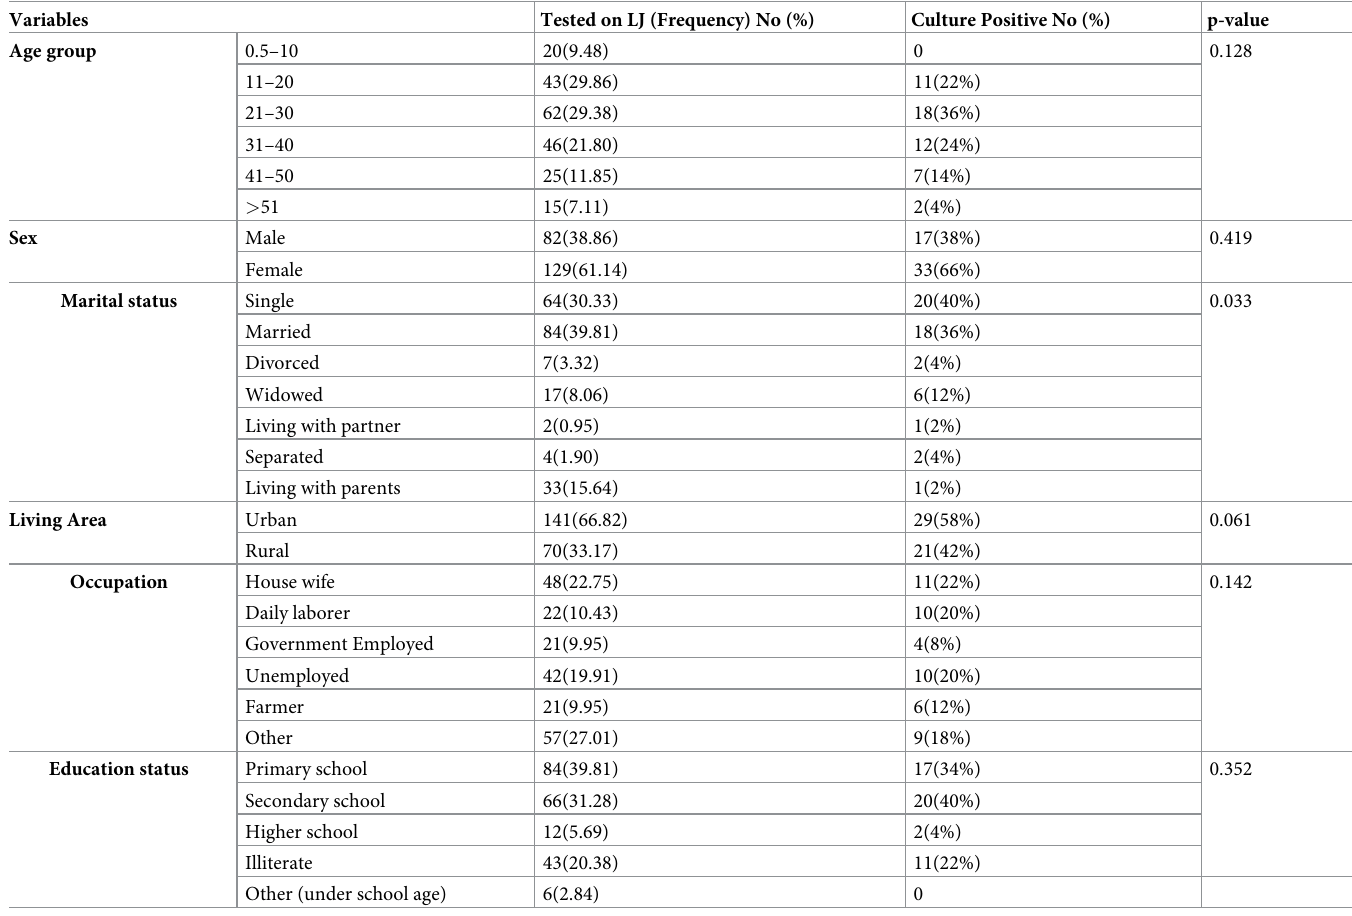
Table 1. Socio-demographic characteristics status of study participants’ data drowns from ALERT and St. Peter TB specialized hospital. Addis Ababa, Ethiopia (n = 211) 2020. Variables Tested on LJ (Frequency) No (%) Culture Positive No (%)